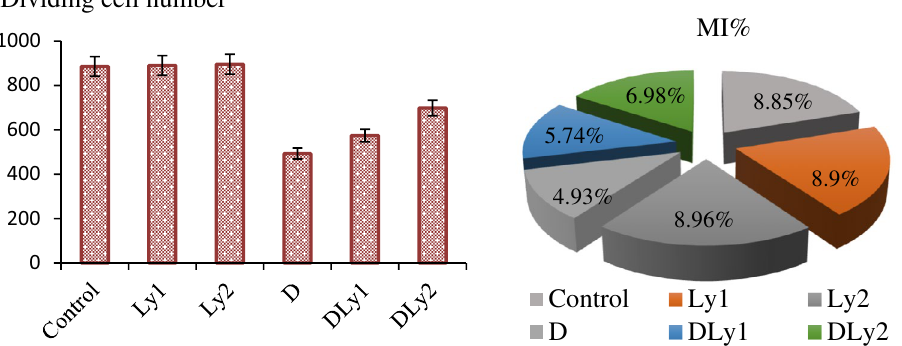
Figure 3. The effects of dithane and lycopene treatments on dividing cell numbers and MI (%). 10,000 cells were scored for each group to evaluate for MI.